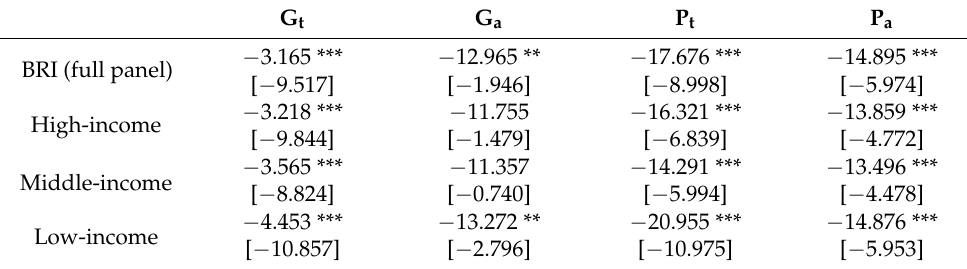
Table 4. Westerlund panel cointegration test results in BRI economies.